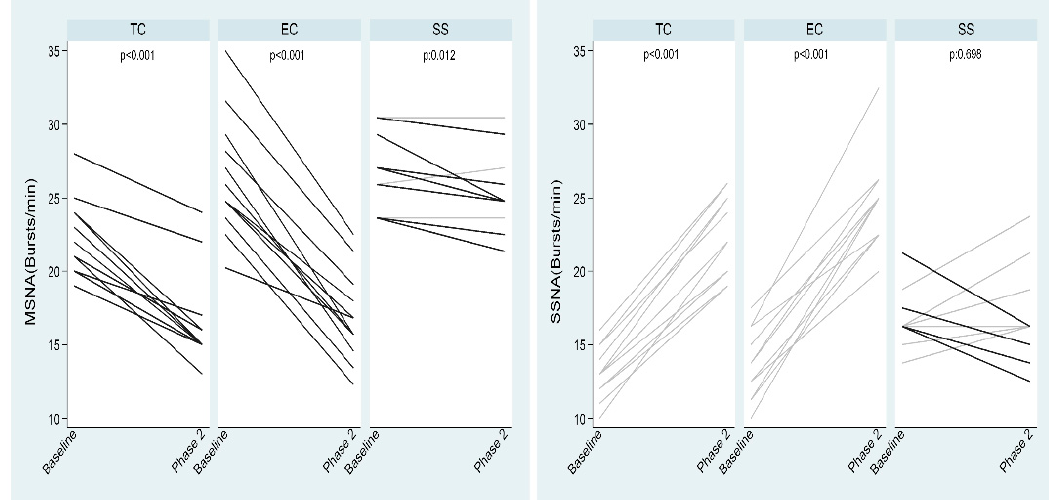
Figure 5. Changes in MSNA and SSNA by TC, EC and sham smoking. EC, electronic cigarette; MSNA, muscle sympathetic nerve activity; SSNA, skin sympathetic nerve activity; TC, tobacco cigarette, SS, sham